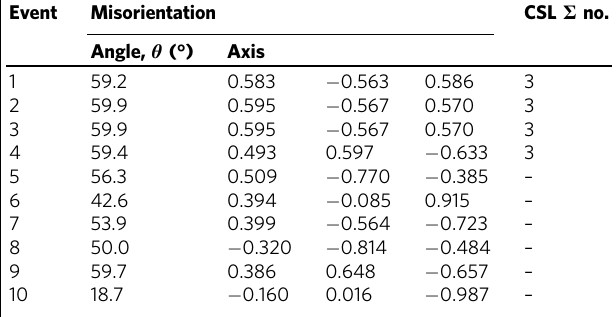
Table 2 Misorientation axes (de fi ned in the crystal coordinate system of grain 1) and angles as well as the coincidence site lattice (CSL) designations for crack- resistant GBs in the ten CDEs found in our data Event Misorientation